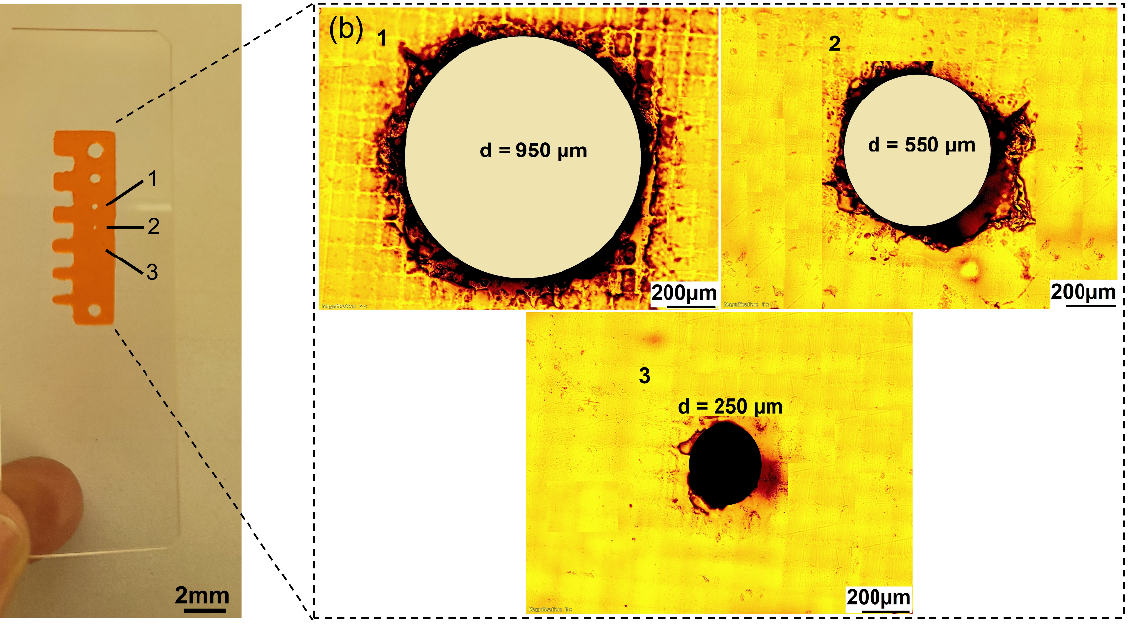
Figure 5. ( a ) Resolution test using a DLP 3D-printed comb structure. ( b ) Analysis of the circular cavities under the microscope for determination of the maximum printing resolution.